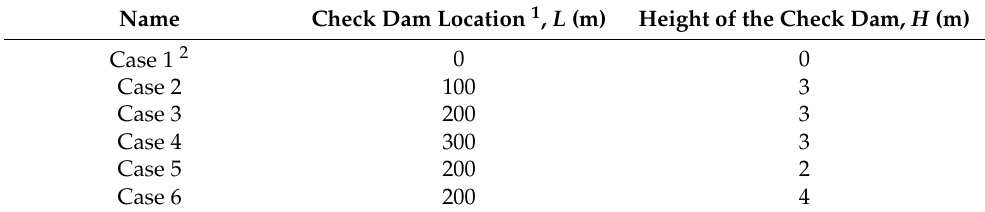
Table 3. Summaries of setting check dam in numerical